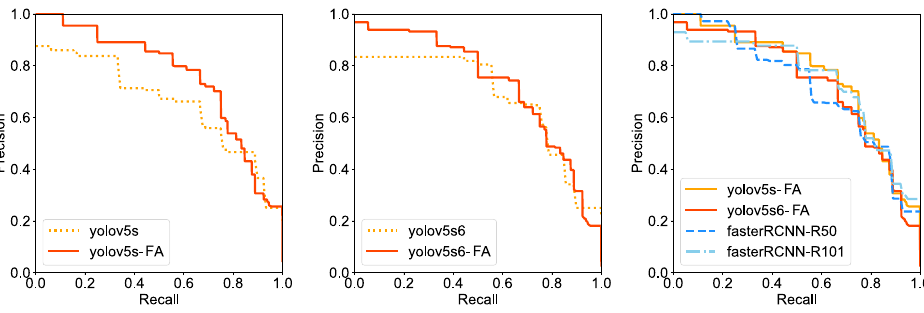
Figure 7. Three group of PR curves, from top to bottom are PR curves of: YOLOv5s and YOLOv5s with FA, YOLOv5s6 and YOLOv5s6 with FA, and two YOLO models with FA compared with two Faster R-CNN models.